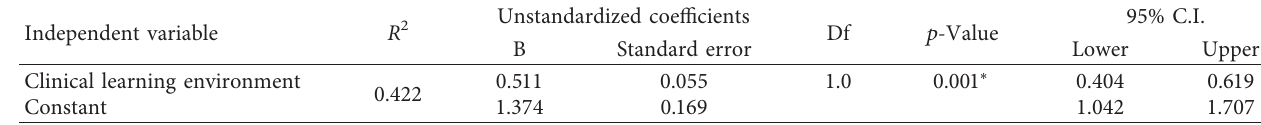
Table 5: Strength of association between clinical learning environment and clinical rotation experience of respondents. Independent variable R 2